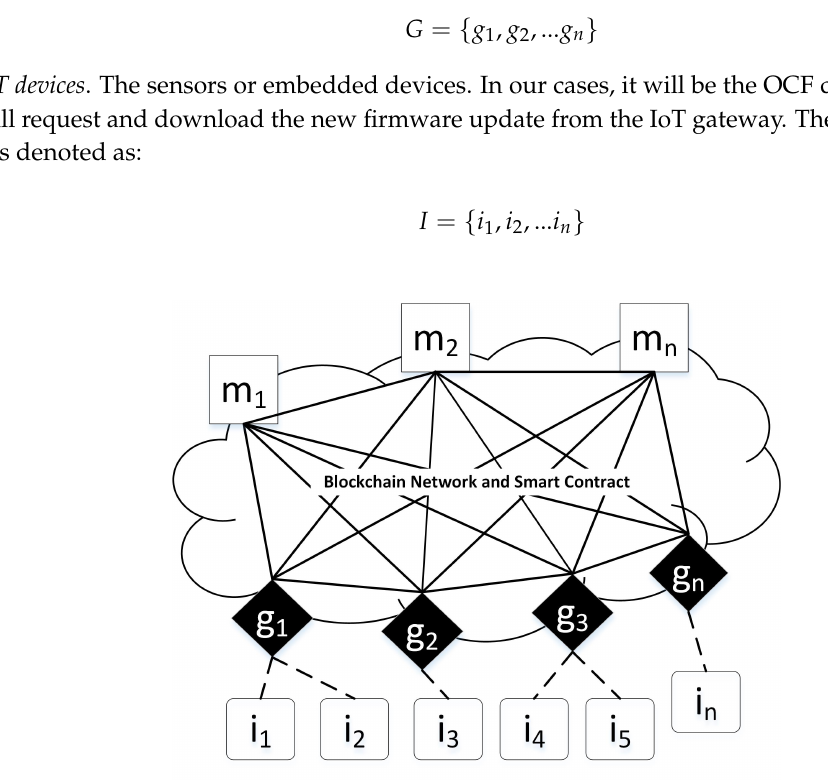
Figure 2. Our proposed blockchain-based firmware update